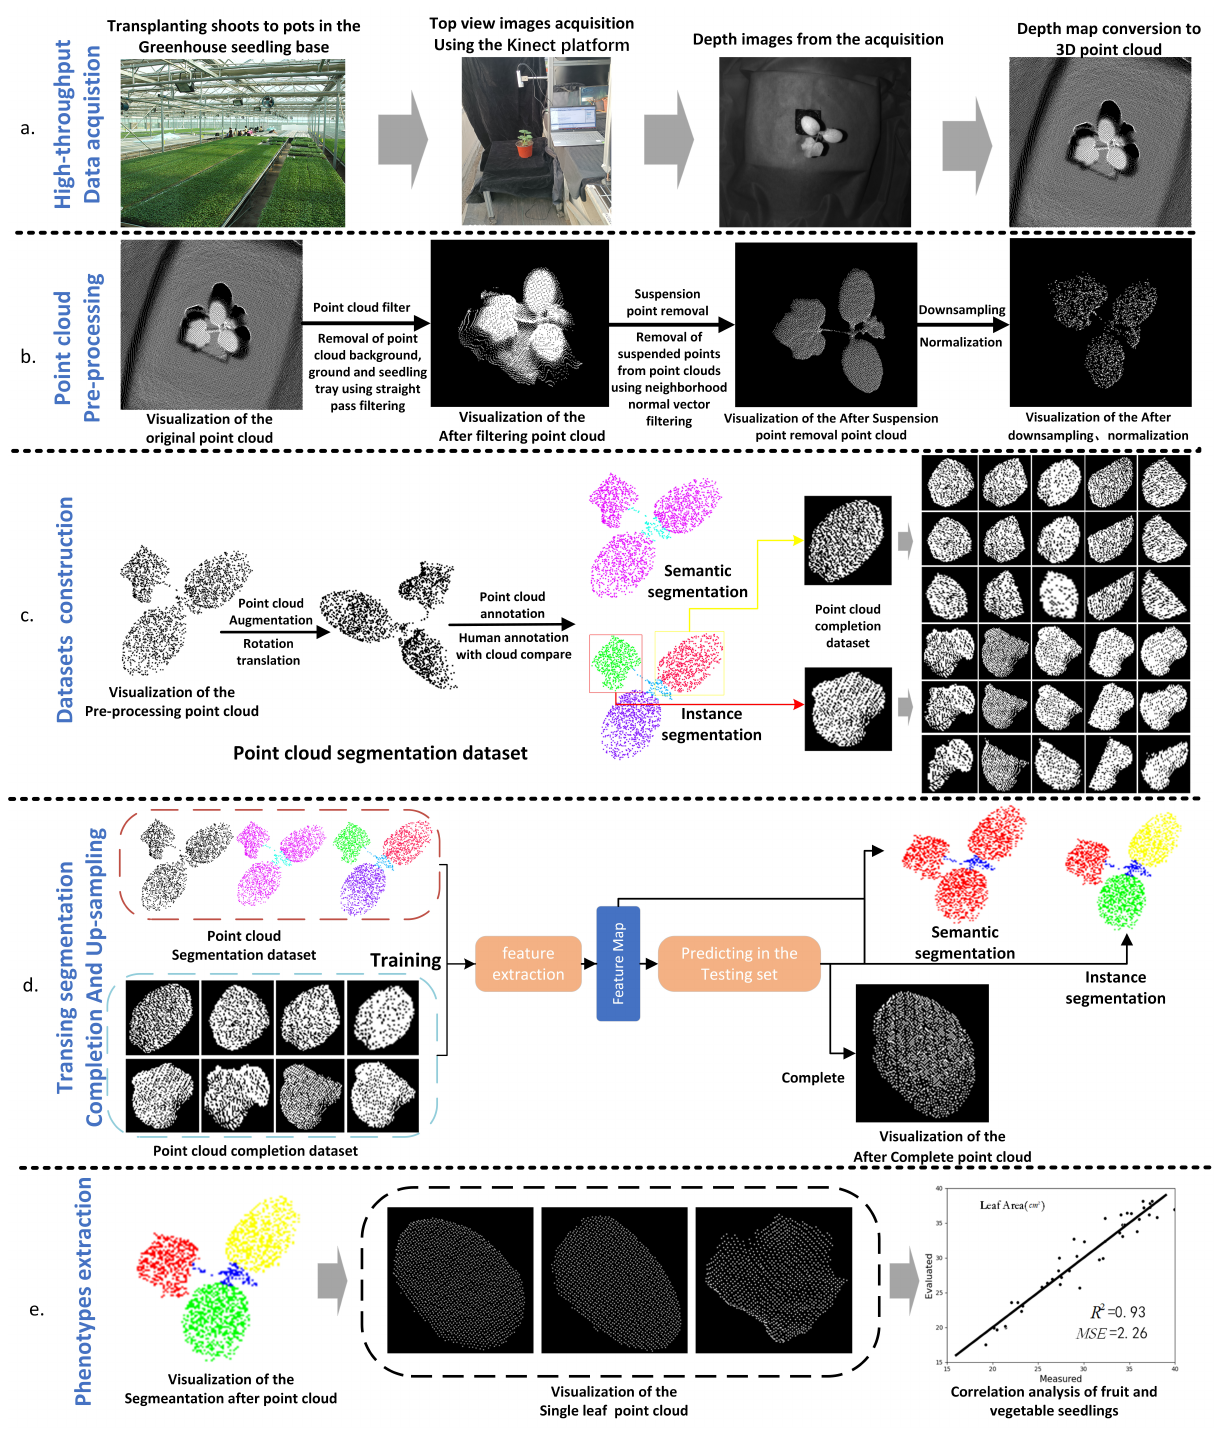
Figure 1. Flowchart of the procedure in this paper. ( a ) High-throughput seeding data acquisition using Kinect. ( b ) Point cloud preprocessing includes point cloud filtering, point cloud down-sampling, and normalization. ( c ) Annotation of data, data enhancement, and missing point cloud datasets construction using Cloud compare software. ( d ) Semantic segmentation of seedlings and missing leaf completion by MIX-Net. ( e ) Phenotype extraction using organ semantic segmentation and missing completion